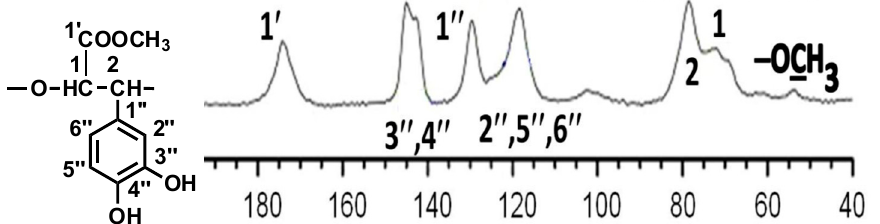
Figure 2. Solid-state 13 C NMR spectrum of PMDHPO. Solid-state 13 C{ 1 H} CP/MAS NMR spectrum, recorded at 9.4 T employing magic-angle spinning at 14.0 kHz and a CP time of 3.0 ms, showing the repeating unit δ (13C) of PMDHPO (ppm). Table 1. The signal assignments of the solid-state 13 C{ 1 H} CP/MAS NMR spectrum of PMDHPGA ( δ , ppm). C Atom No.